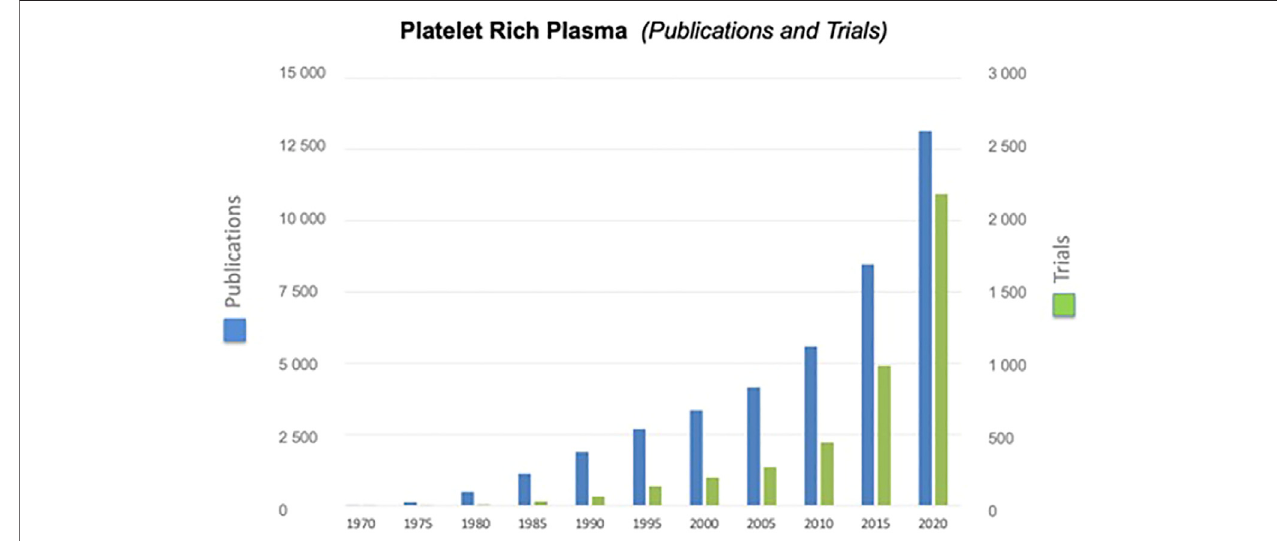
FIGURE3| ExponentialgrowthofpublicationsandclinicaltrialshavingPRPassubject.Informationwasderivedsearchingby “ Platelet-RichPlasma ” thedatabase “ PubMed ” for publications and “ Cochrane library (Title, Abstract, and Keywords) ” for trials.